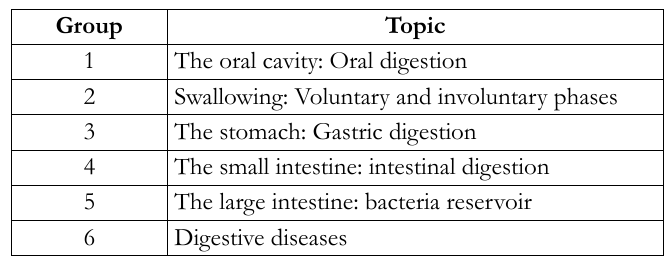
Table 2. Themes of the baccalaureate inquiry